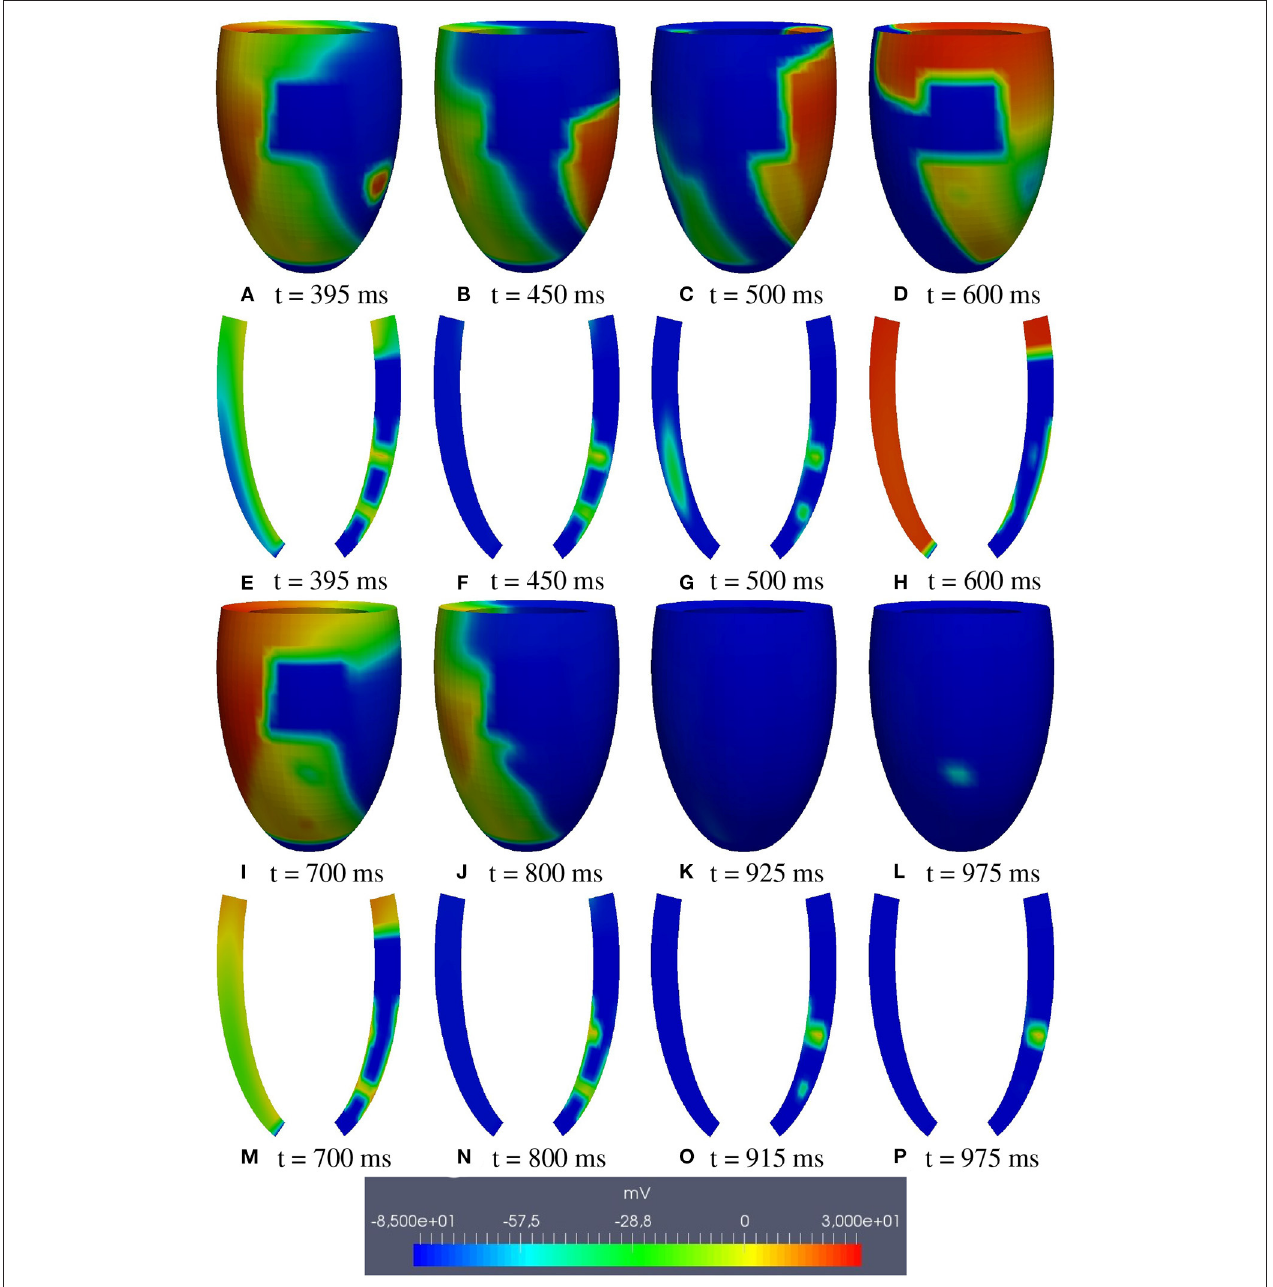
FIGURE 5 | Patient #1. M1 stimulation. (A–P) Transmembrane potential snapshots (t = 395–975 ms) on the epicardial surface and on a transmural section. t = 0 corresponds to the S1 stimulus. The S2 stimulus is applied at t = 350 ms.